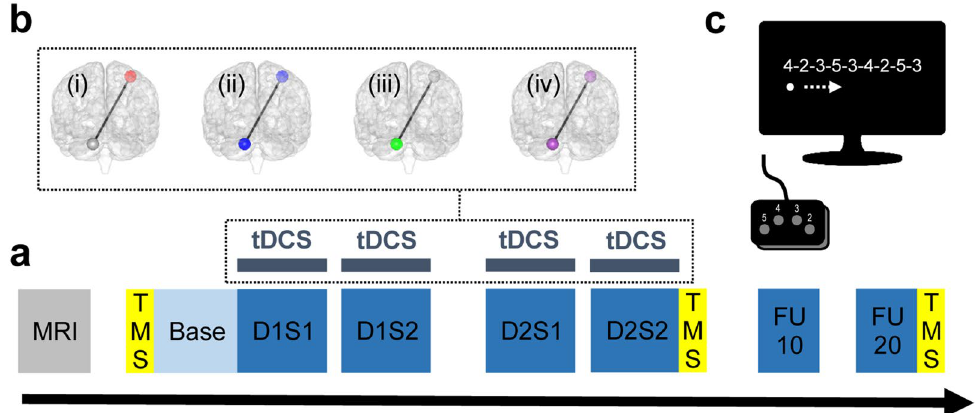
Figure 7. Experimental design. ( a ) Experimental timeline: a novel motor skill was trained over four sessions equally distributed over two training days (D1S1, D1S2, D2S1, D2S2). Prior to start of the training phase, baseline level of task performance was quantified (Base). Task retention was assessed circa 10 and circa 20 days after the training phase (FU10 and FU20). tDCS was applied simultaneously to the training sessions in a randomized, double-blind, sham controlled, parallel design applying one of the four conditions (please see also figure panel b): (1) red: monofocal M1 stimulation, (2) blue: sham stimulation, (3) green: monofocal cerebellar stimulation, (4) violet: sequential multifocal motorcortical-cerebellar stimulation (schematic illustrations created with BrainNet Viewer 85 ). Further assessments included ppTMS (short intracortical inhibition—SICI at